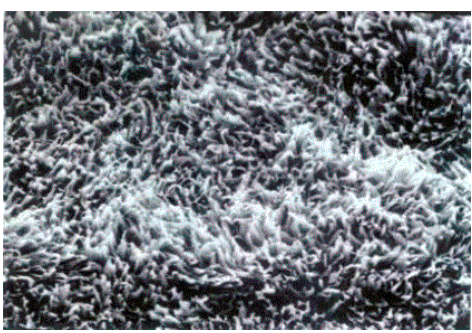
Figure 2. Scanning electron microscopy (SEM) image of a 10k× fold magnification black oxide treated surface. Reprinted with permission from [17]; Copyright 2002 Atotech GmbH.